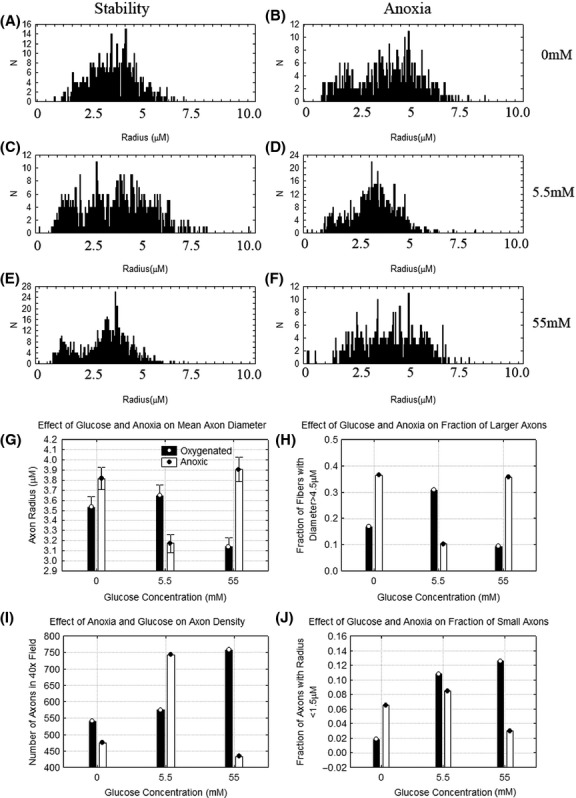
Quantitative properties of the toluidine blue images. (A) Distribution of axon radii in nerves that are continuously oxygenated at 0 mmol/L glucose, (B) Distribution of axon radii in nerves subjected to intermittent anoxia at 0 mmol/L glucose, (C) Distribution of axon radii in nerves that were continuously oxygenated at 5.5 mmol/L glucose, (D) Distribution of axon radii in nerves that were exposed to intermittent anoxia at 5.5 mmol/L glucose, (E) Distribution of axon radii in nerves that were continuously oxygenated at 55 mmol/L glucose, and (F) Distribution of axon radii in nerves that were exposed to intermittent anoxia at 55 mmol/L glucose. The error bars represent 95% confidence intervals. Changes in the (G) mean axon radius, (H) Fraction of large axons, (I) Number of axons per 40× field, and (J) Fraction of amall axons in each condition.